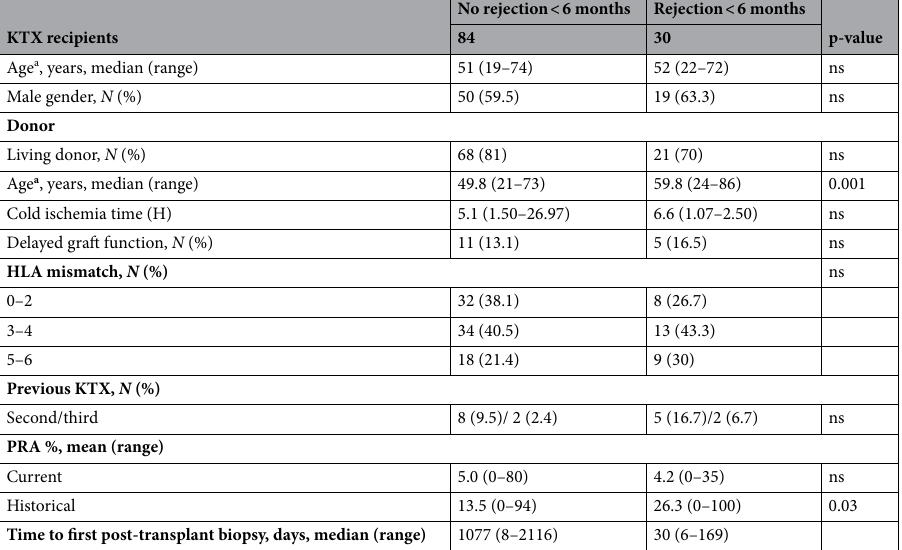
Table 1. Patient characteristics. a Age at transplantation. KTx kidney